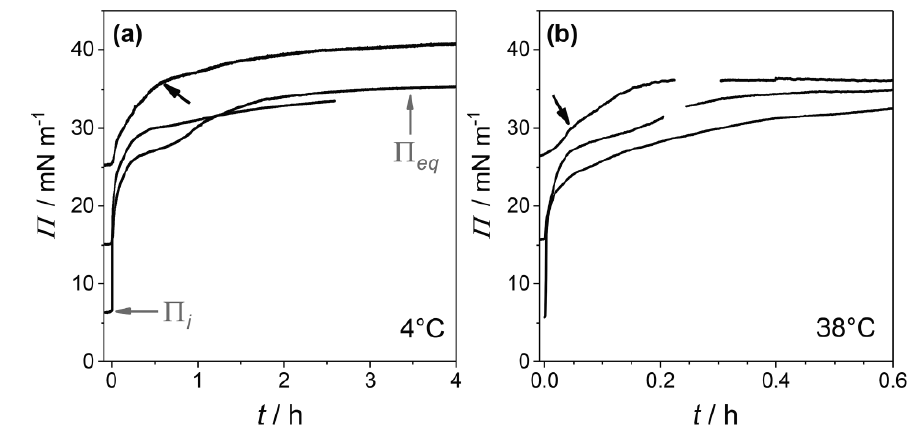
Figure 14. Surface pressure-time adsorption kinetics for a DMPC monolayer after the start of buffer sub-phase exchange (50mM phosphate buffer, pH 7.4) against β -aescin solution (same conditions) until reaching equilibrium pressure Π eq . The experiments were carried out at ( a ) 4 ◦ C and ( b ) 38 ◦ C for different initial pressures Π i ≈ 5, 15, and 25mNm − 1 . The arrows mark an intermediate cusp which is explained in the main text. Reproduced with permission from Sreij et al. [46], ©2017 American Chemical Society.